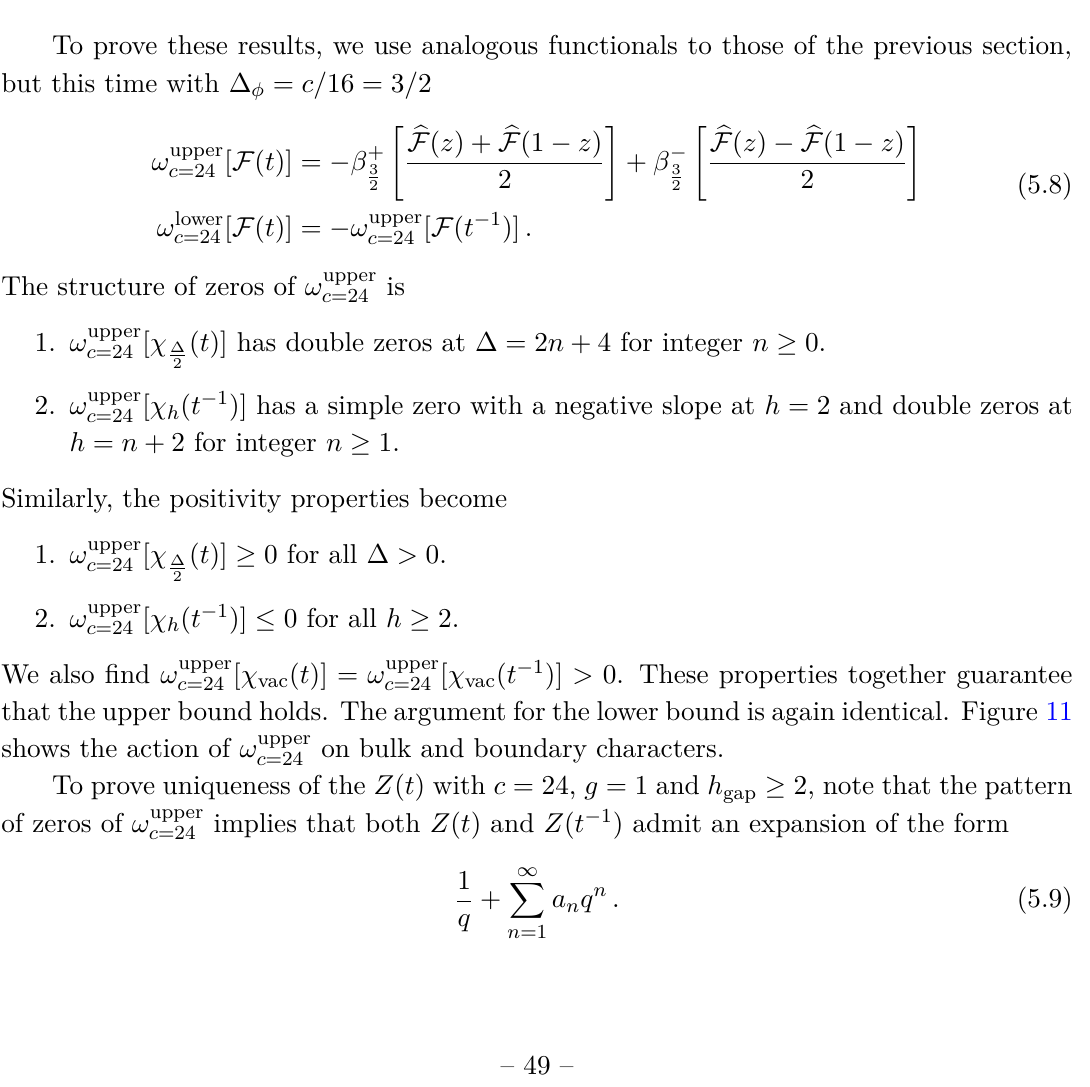
Figure 11. The action of the functional ω upper boundary (lower plot) characters. For clarity, we plot e 3∆ ω upper The numerical functional at N = 111 agrees with the analytic curve to an excellent